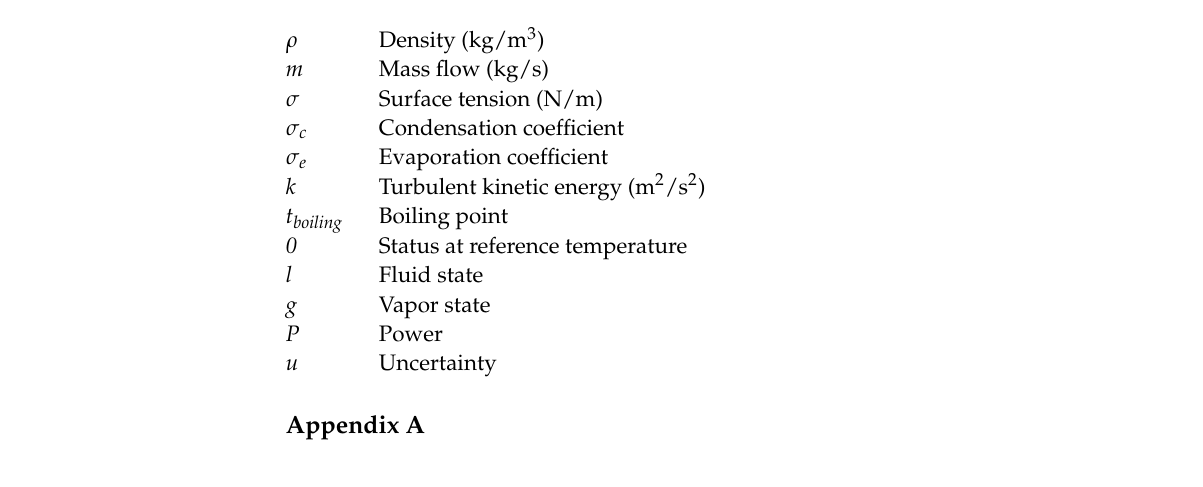
Table A1. The thermal properties of HFE 7100